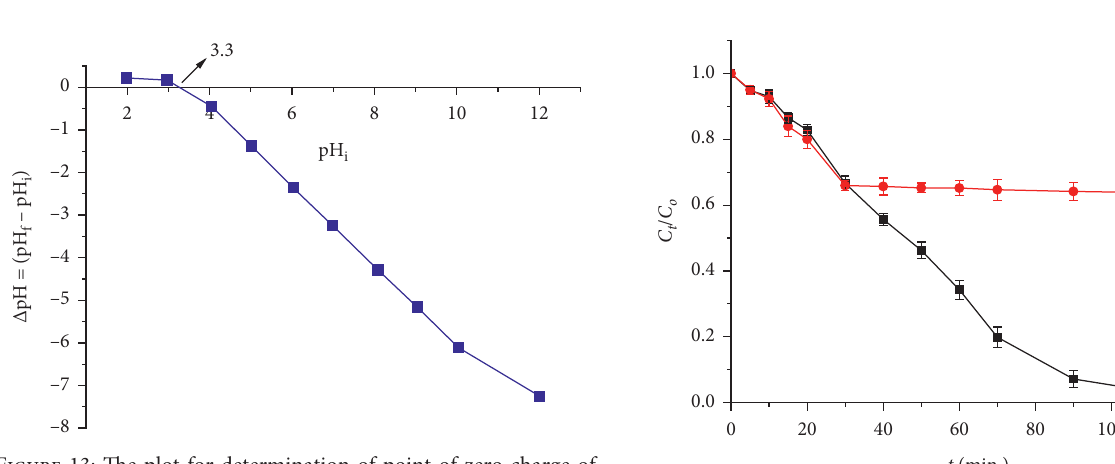
Figure 13: The plot for determination of point of zero charge of MIL-53(Fe).